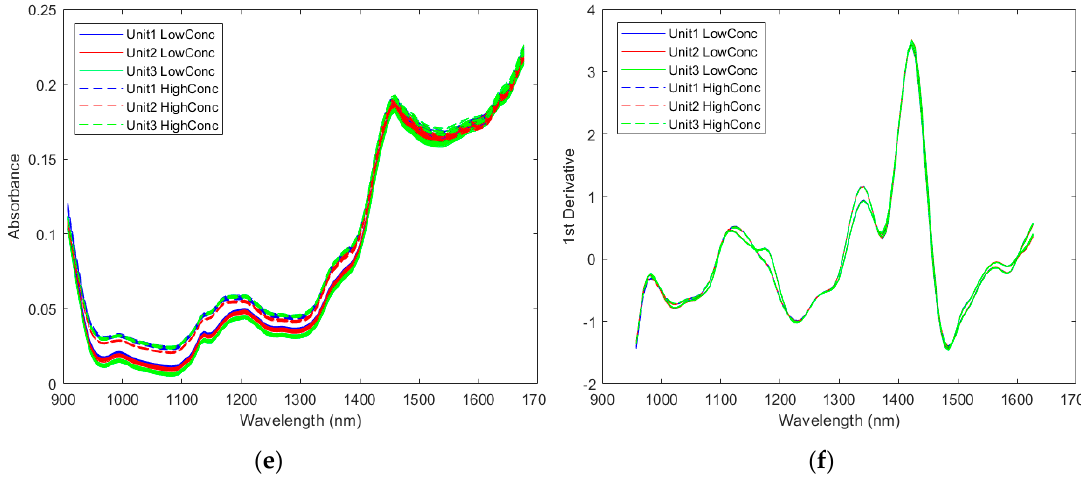
Figure 2. Spectra of samples with the highest and the lowest active pharmaceutical ingredient (API) concentrations measured by three instruments: ( a ) selected raw spectra based on the acetylsalicylic acid (ASA) concentration; ( b ) selected preprocessed spectra based on the ASA concentration by Savitzky-Golay 1st derivative (5 smoothing points and 2nd polynomial order) and SNV; ( c ) selected raw spectra based on the ascorbic acid (ASC) concentration; ( d ) selected preprocessed spectra based on the ASC concentration by Savitzky-Golay 2nd derivative (7 smoothing points and 3rd polynomial order) and SNV; ( e ) selected raw spectra based on the caffeine (CAF) concentration; ( f ) selected preprocessed spectra based on the CAF concentration by Savitzky-Golay 1st derivative (17 smoothing points and 3rd polynomial order) and SNV.